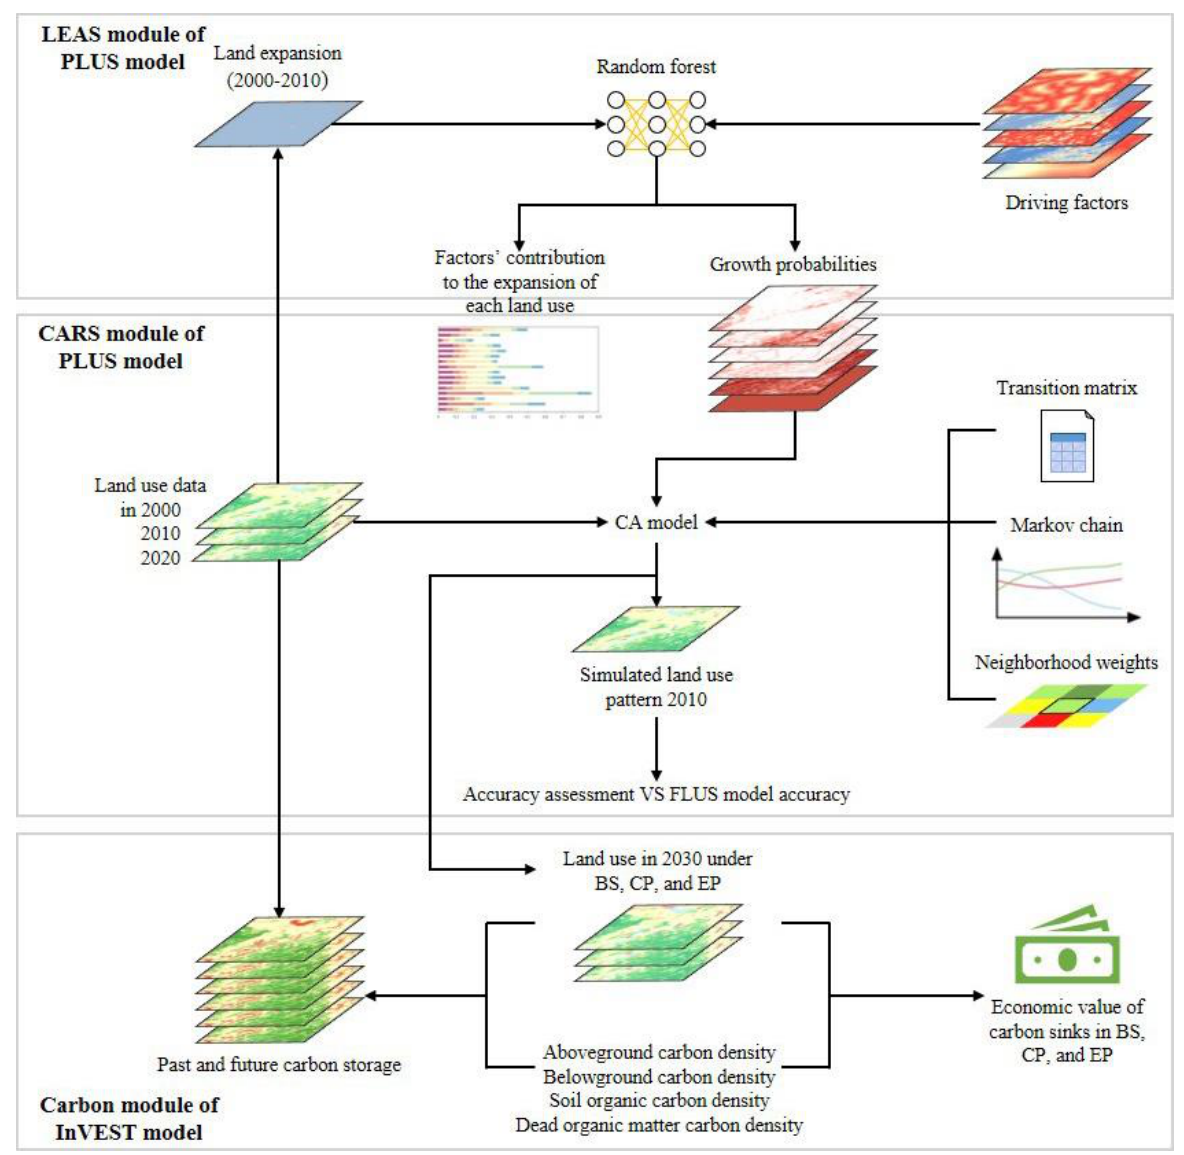
Figure 2. Overall experimental procedure of the study.